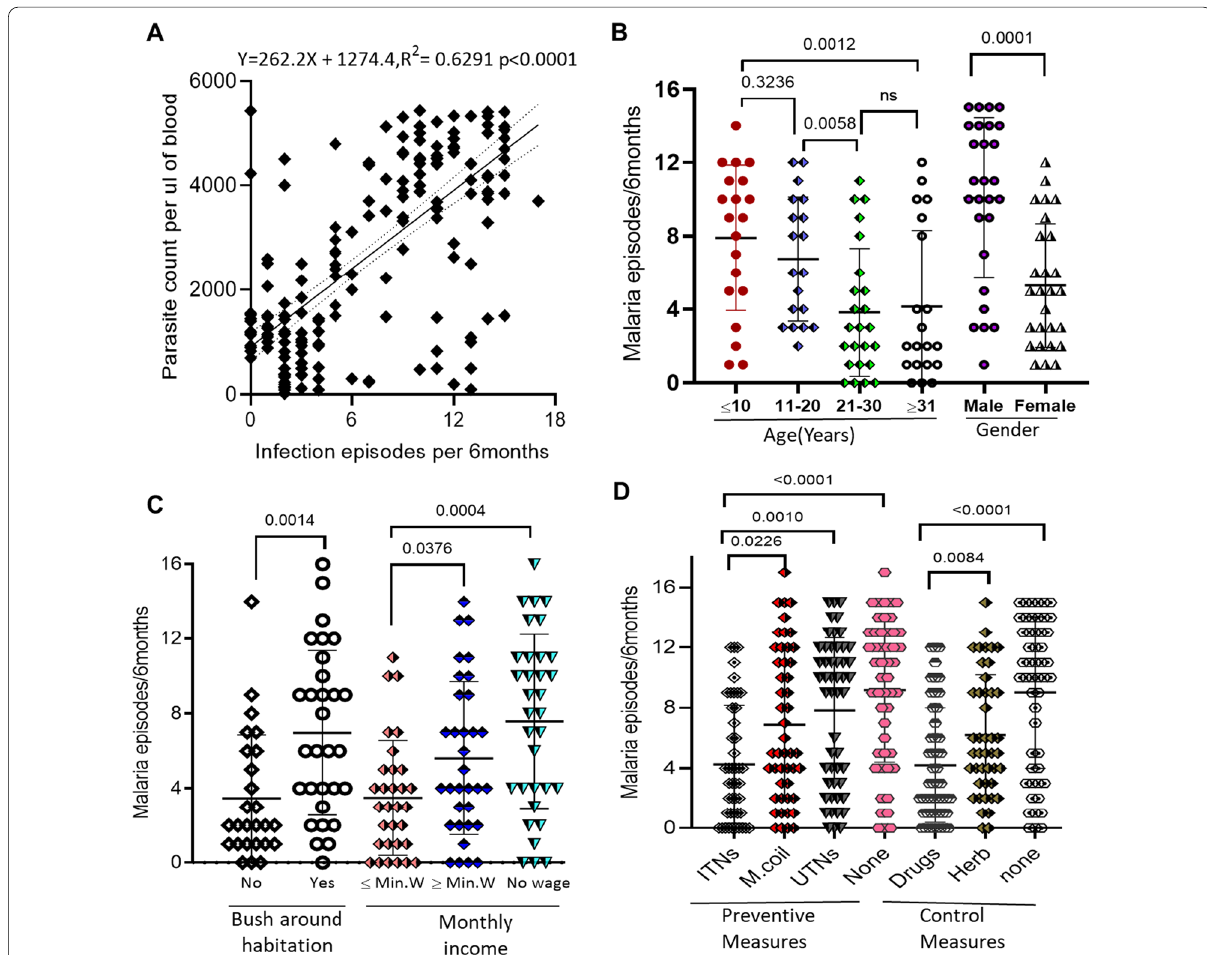
Fig. 3 Correlation of malaria episodes with respect to malaria intensity, age and socioeconomic status. ITNs insecticide-treated nets, M. coil mosquito coil, UTNs non-insecticide-treated